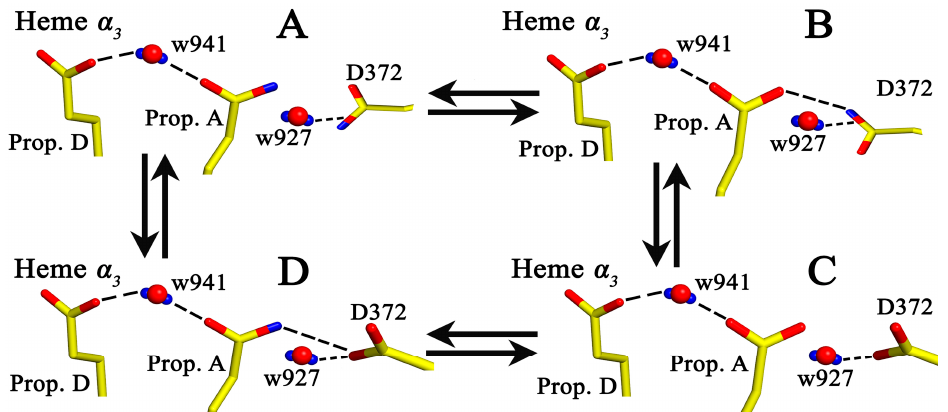
Figure 7. Protonic connectivity between the ring-A propionate of heme a 3 , the D372, and the water molecule w927. Blue, red and yellow colors represent protons, oxygen and carbon atoms, respectively. In states B and D , a single proton is shared between ring-A propionate of heme a 3 and D372, while in state A , ring-A propionate of heme a 3 and D372 are protonated and in state C , ring-A propionate of heme a 3 and D372 are deprotonated.